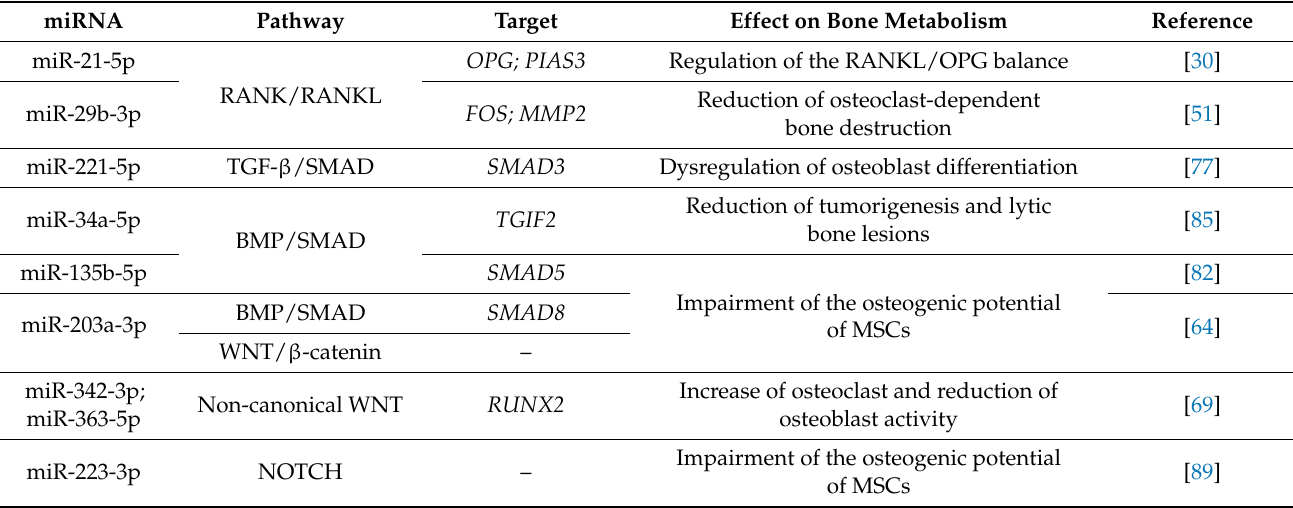
Table 1. MicroRNAs (miRNAs) implicated in pathways affecting multiple myeloma bone disease (MMBD).